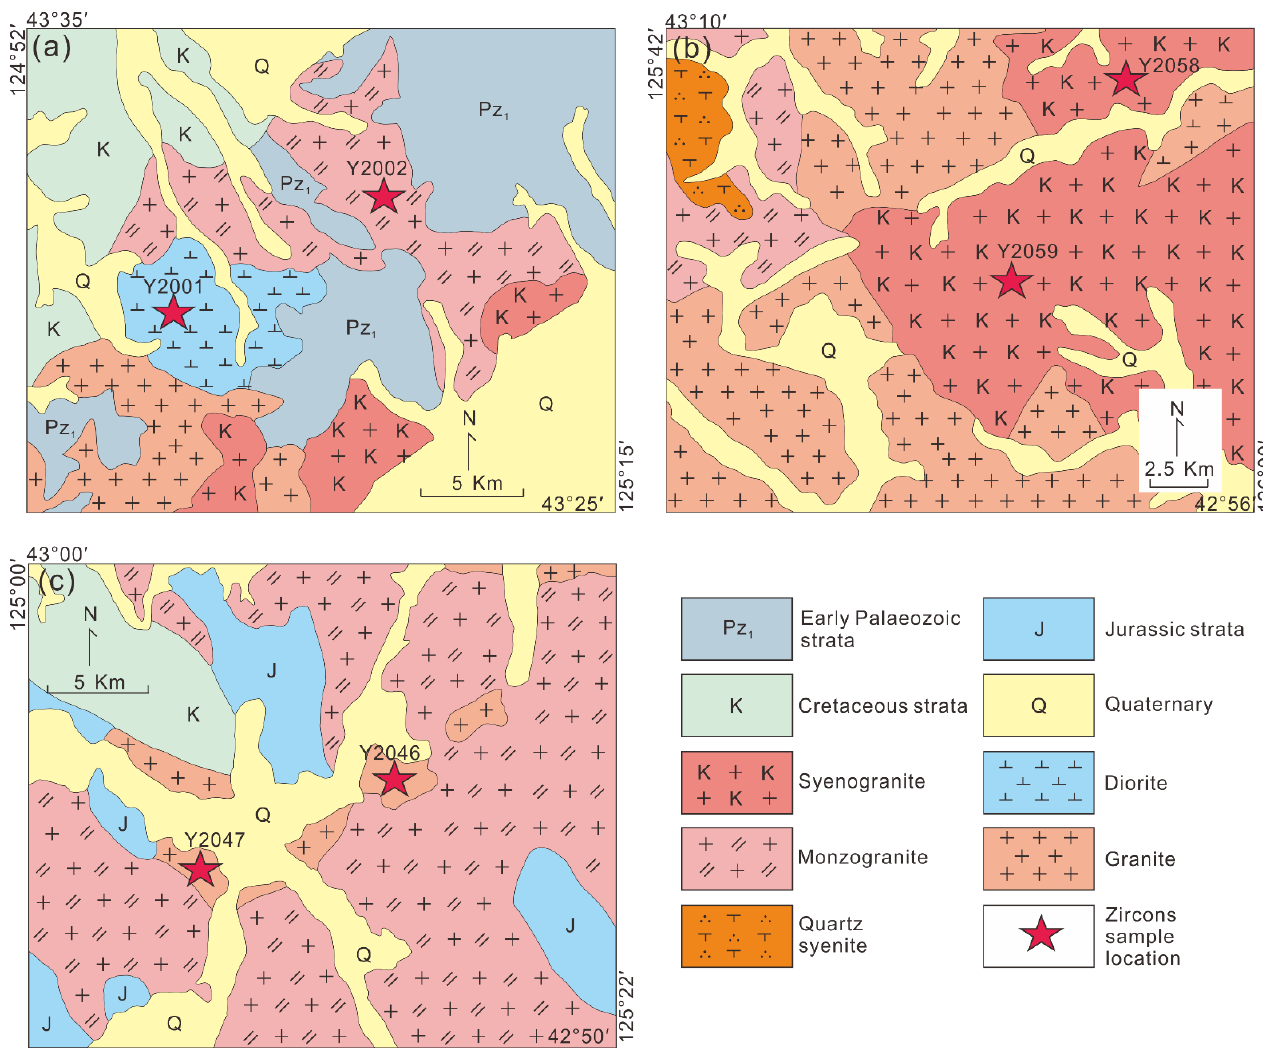
Figure 3. Detailed geological map of the ( a ) Nanweizi, ( b ) Taipinling, and ( c ) Shoushan area in the central Jilin Province, showing the zircon sample locations. All samples are massive, with a medium-coarse grained granitic texture (Figure 4). The quartz diorites consist of plagioclase (60 – 65%), hornblende (~15%), quartz (~10%),